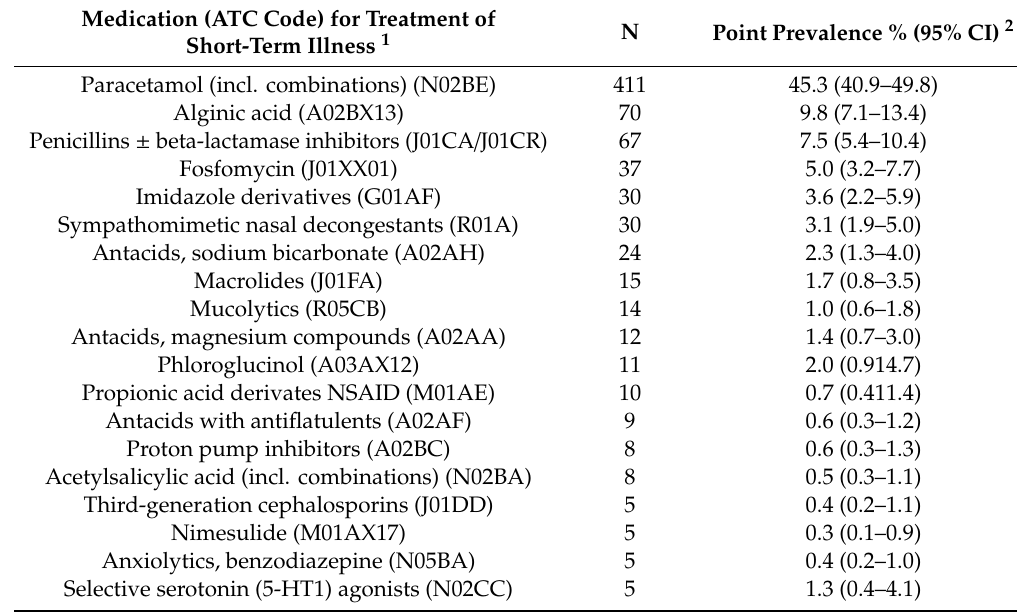
Table 2. Most common medications used in pregnancy to treat short-term or longer-term illnesses ( n =